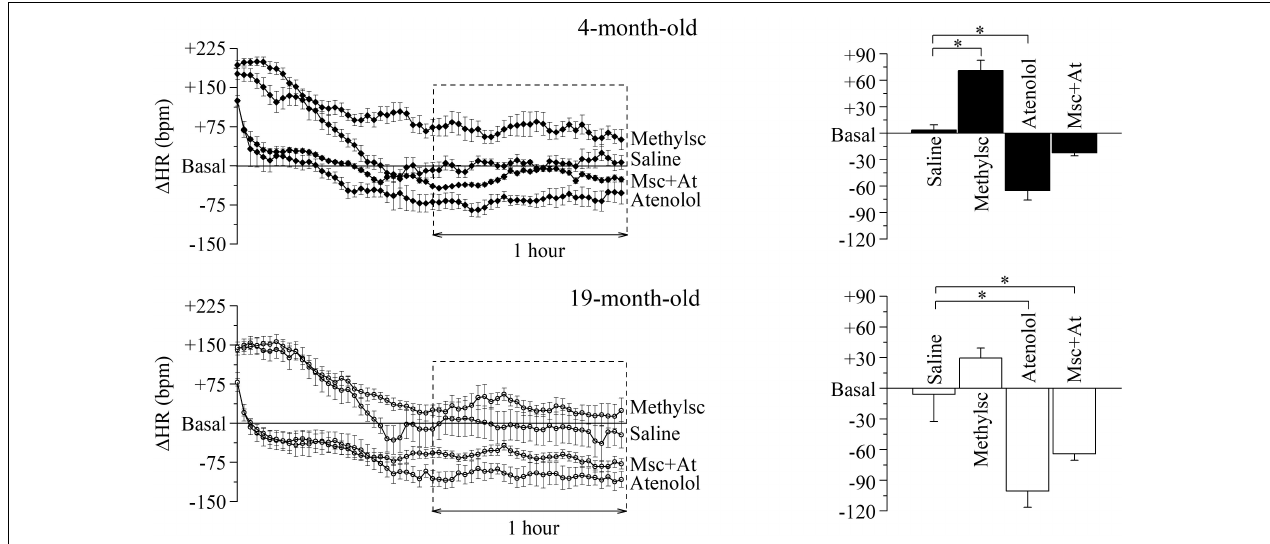
FIGURE 2 | Age-related differences in the autonomic modulation of heart rate. Heart rate changes ( (cid:49) HR) after i.p. injection of vehicle (Saline) and autonomic modulator drugs (Methylscopolamine, Atenolol and Methylscopolamine + Atenolol) in 4 month-old ( n = 10) and 19 month-old ( n = 9) freely moving mice. The left-hand panels represent the time courses of (cid:49) HR recorded from the moment of the injection; each point represents the mean (cid:49) HR of a 2-min period. Saline was employed to identify the time span which is needed by the animals to recover from the handling-induced stress (60 min after the injection the HR returned similar to the mean basal HR recorded for 60 min before drugs administration, Basal). The right-hand panels report mean (cid:49) HR values recorded during the second hour post-injection. Data are reported as mean ± SEM. ∗ p < 0.05, one-way ANOVA for repeated measures followed by Fisher’s LSD post hoc